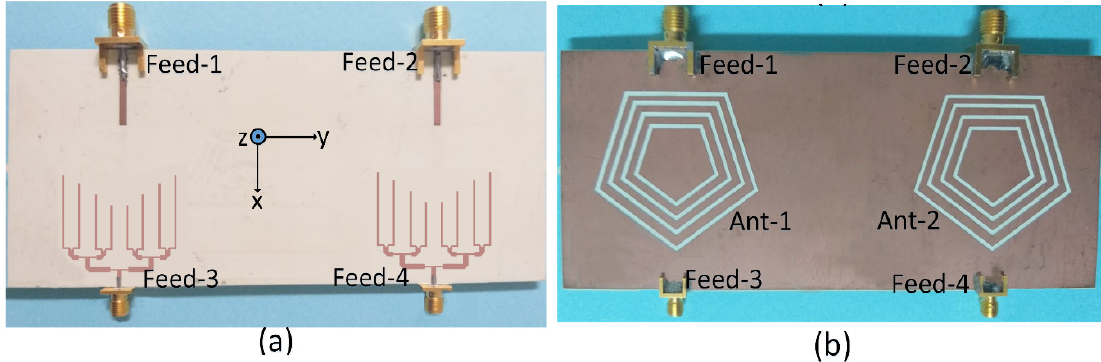
Figure 1. Proposed MIMO antenna: ( a ) Top layer, ( b ) GND plane.